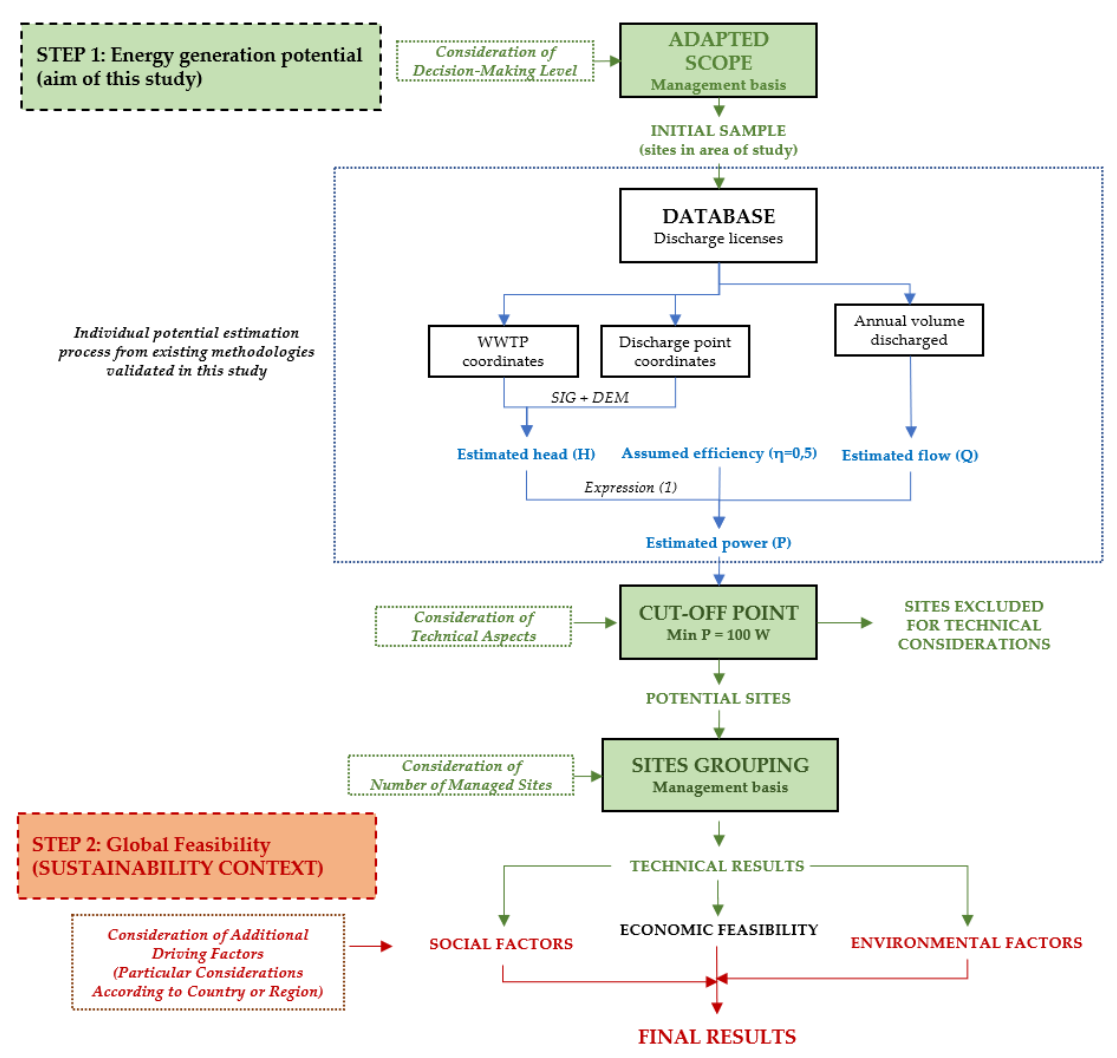
Figure 7. Proposed approach to adapt hydropower assessment methodologies within the sustainability framework.